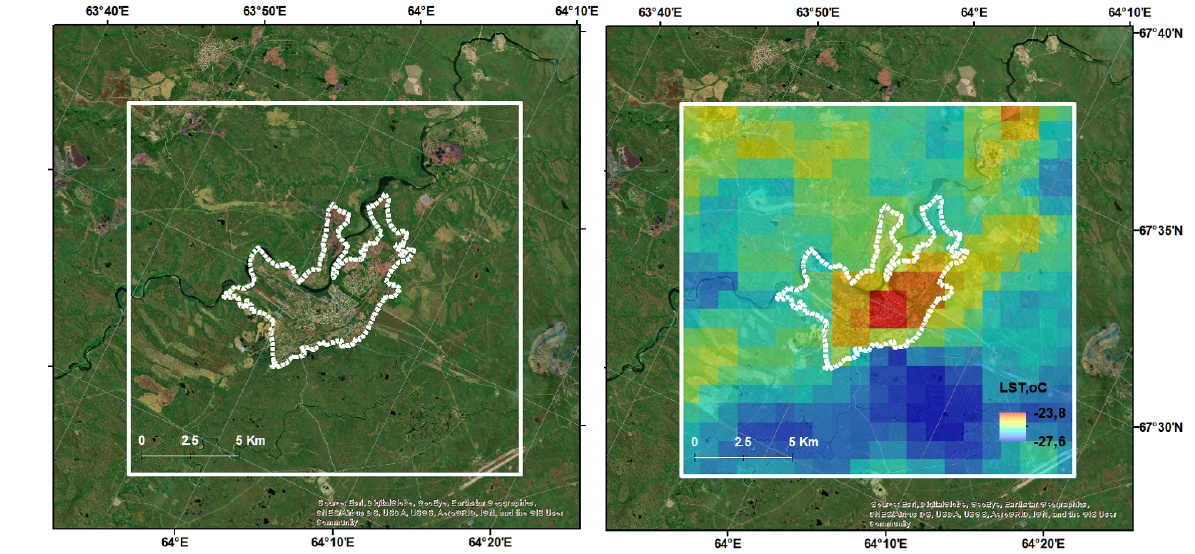
Figure 2. Example of the surface urban heat island in Vorkuta (Russia). Left panel: georeferenced satellite image of the city with su- perimposed urban boundary by the dashed line; right panel: superimposed mean winter LST in the same area. Red colours show higher temperature, blue colours – lower temperature. The warmest central urban pixels (1 × 1km 2 ) are clearly identifiable. Data: averaged MODIS LST for December–February 2000–2016. Source: Esri, Digital globe, GeoEye, Earthstar Geographics, CNES/Airbus DS, USDA, USDS, AeroGrid, IGN, and the GIS user